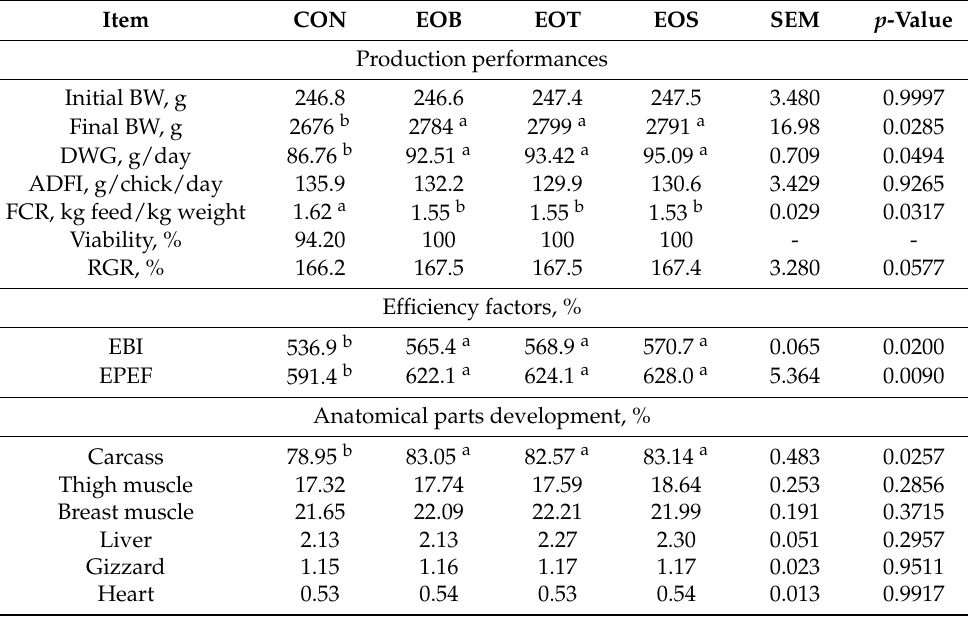
Table 2. Effect of dietary supplements on production performances, efficiency factors and organ development in broiler chickens supplemented with essential oils.